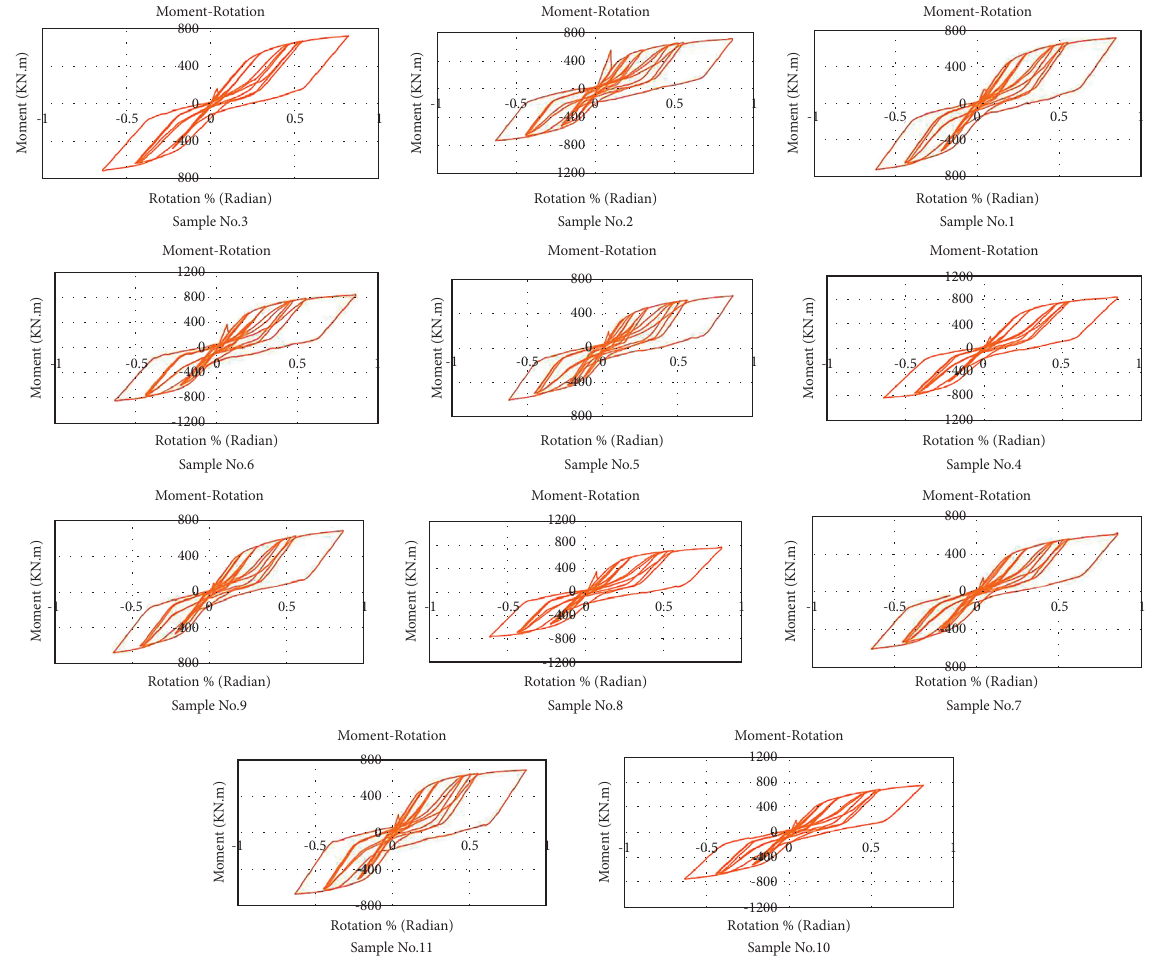
Figure 13: Anchor-period hysteresis diagram in the first 17 cycles for samples 1 to